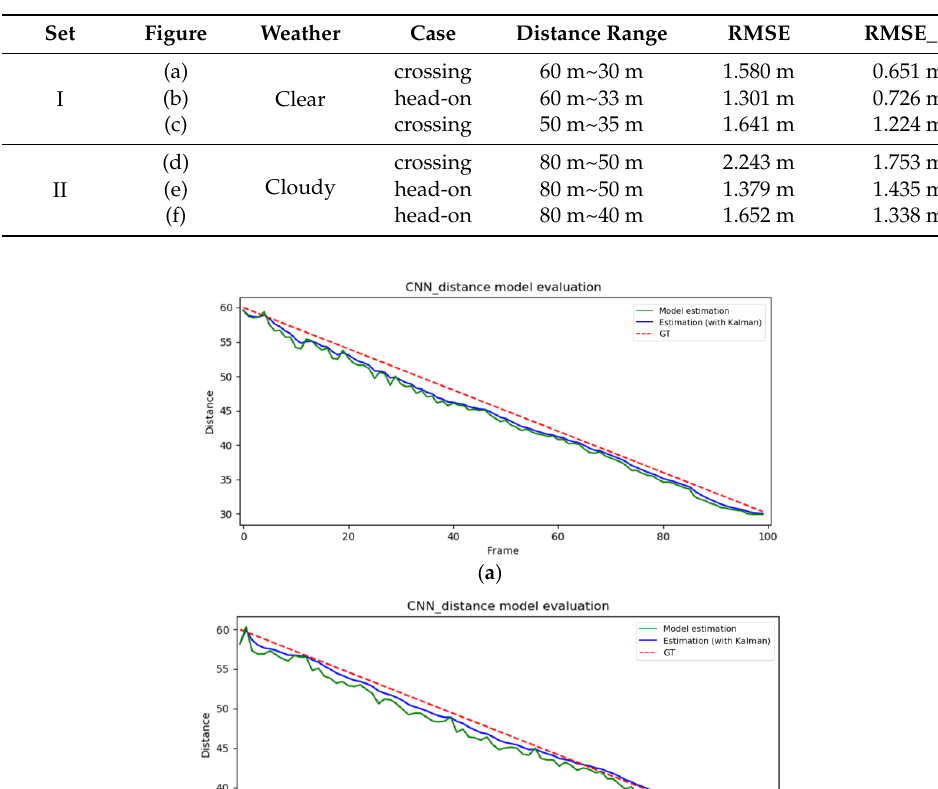
Table 4. Estimated distance vs. ground truth.